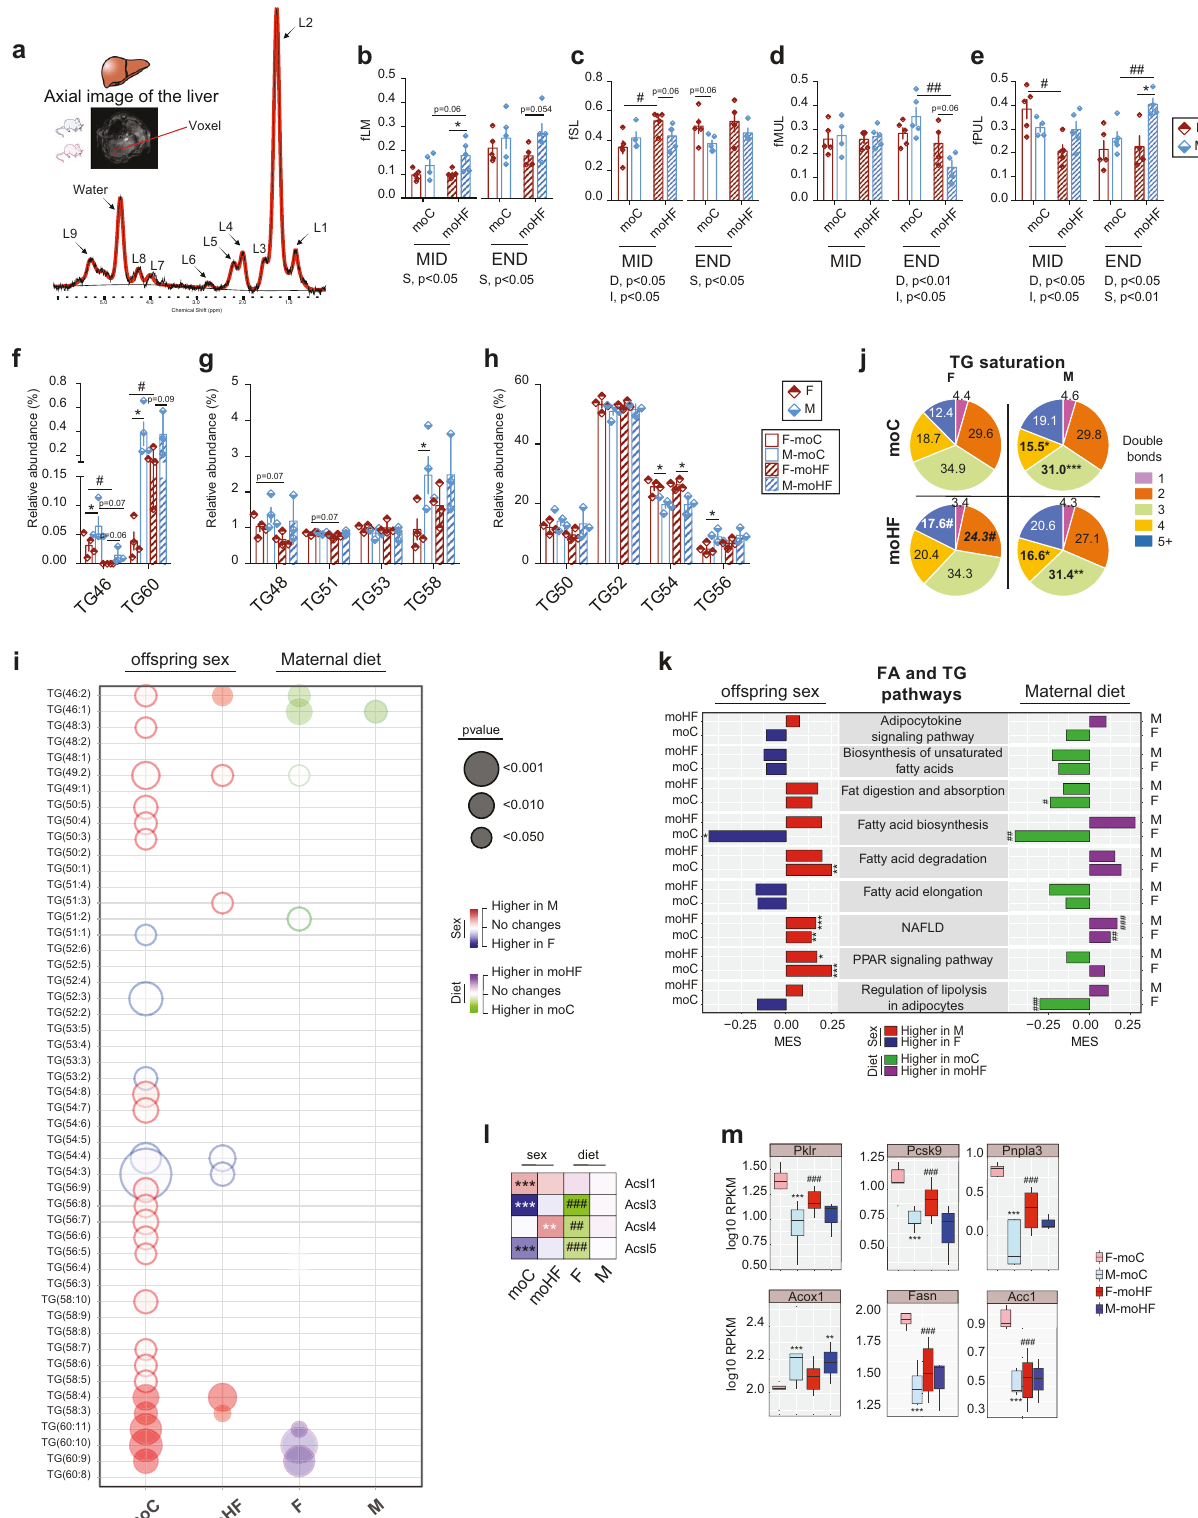
proportion of TG-containing 2-double bonds in females, which is in line with the modulation of the desaturases ( Scd1 , Fads1/2 ) gene expression by MO (Table S2).